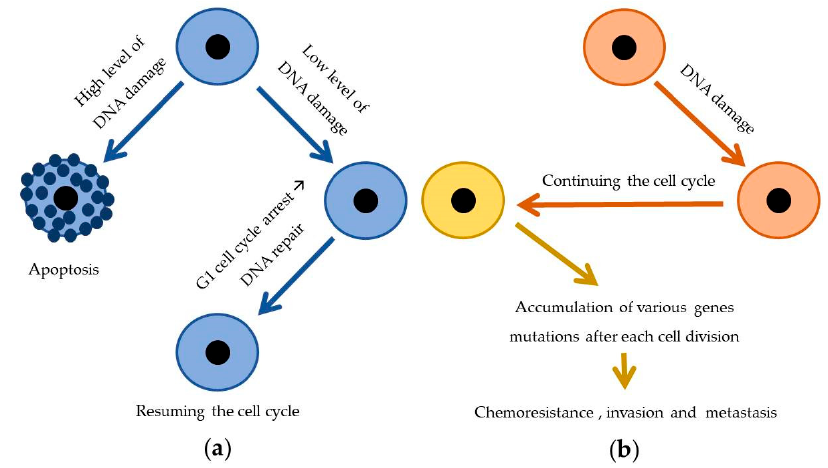
Figure 3. Differences in TP53 gene expression level between normal ( a ) and cancer cells ( b ) and consequences thereof: ( a ) accurate level of expression of TP53 gene and ( b ) decreased level of expression of TP53 gene [38].